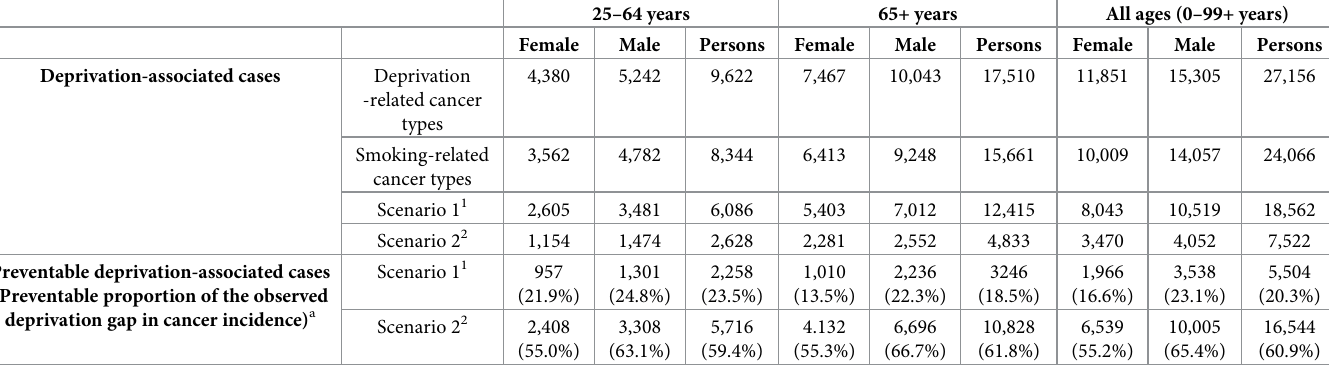
Table 2. Estimated average number of deprivation-associated cases per year for deprivation-related cancer types � and smoking-related cancer types �� , scenario 1 and scenario 2; and the estimated number of deprivation-associated cases and proportion of the observed deprivation gap in cancer incidence that could have been prevented, in England, in